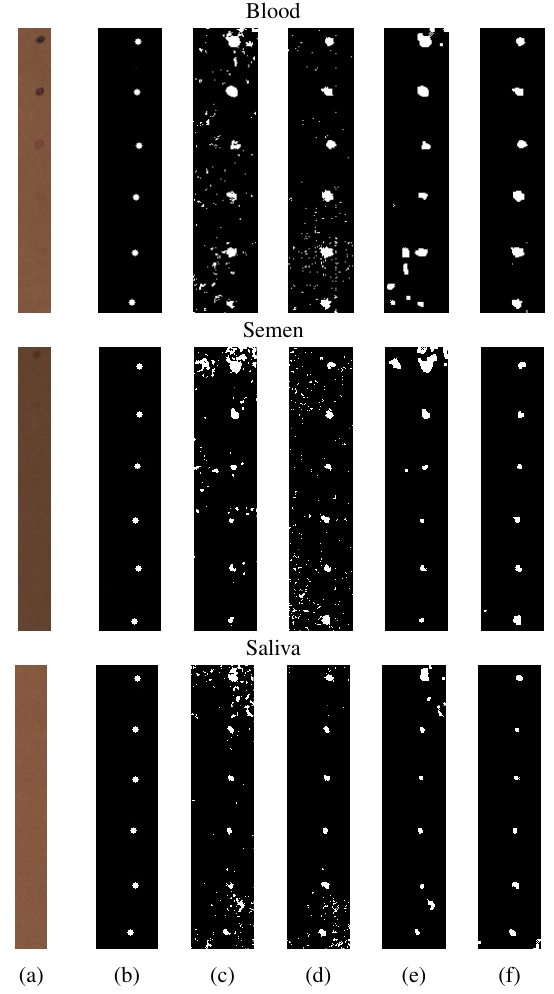
Figure 3: Best band and ratio images I λ numbers under each image. According bands λ i and wavelengths pairs λ i,j are given in Table 1.